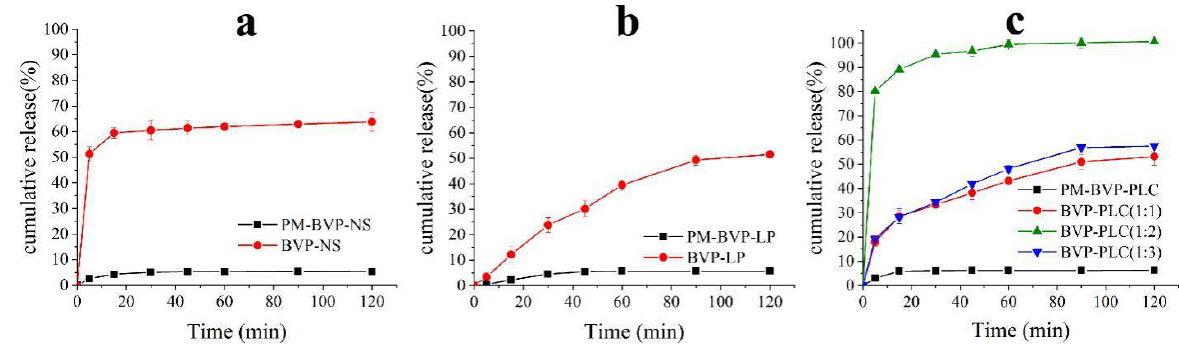
Figure 9. The cumulative release curves of BVP-NS ( a ), BVP-LP ( b ) and BVP-PLC ( c ).